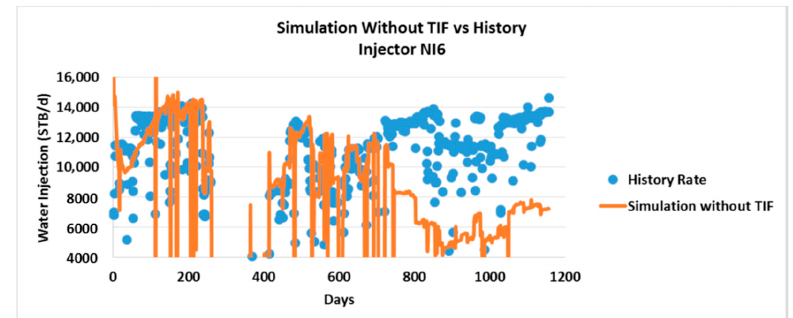
Figure 39. Simulated injection and historical data without TIF after matching reservoir pressure and BHP to reliable data.